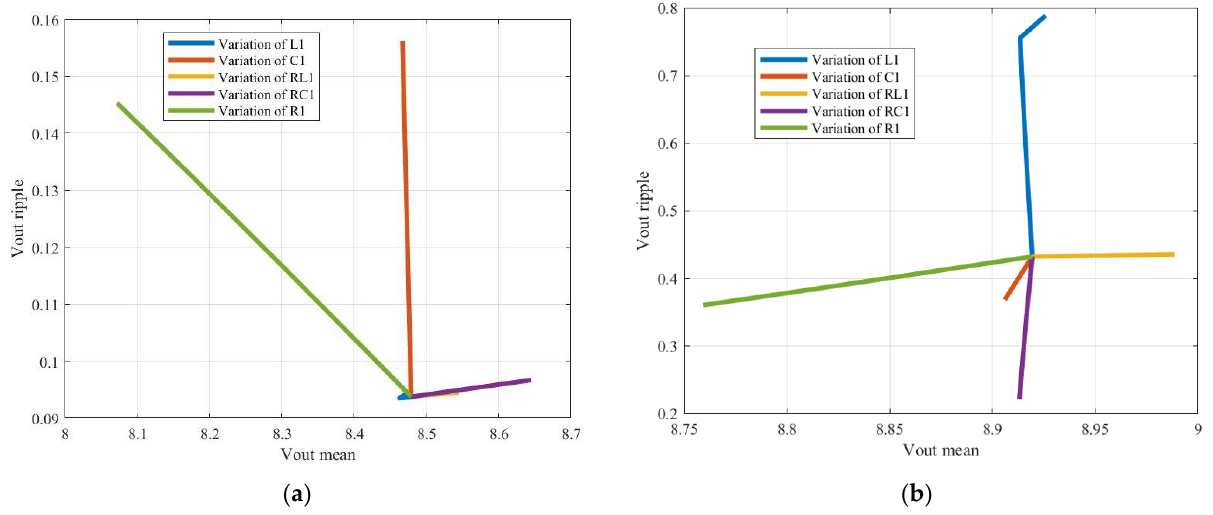
Figure 10. Testability assessment for a boost converter using only output voltage: ( a ) switch-on period ( b ) switch-off